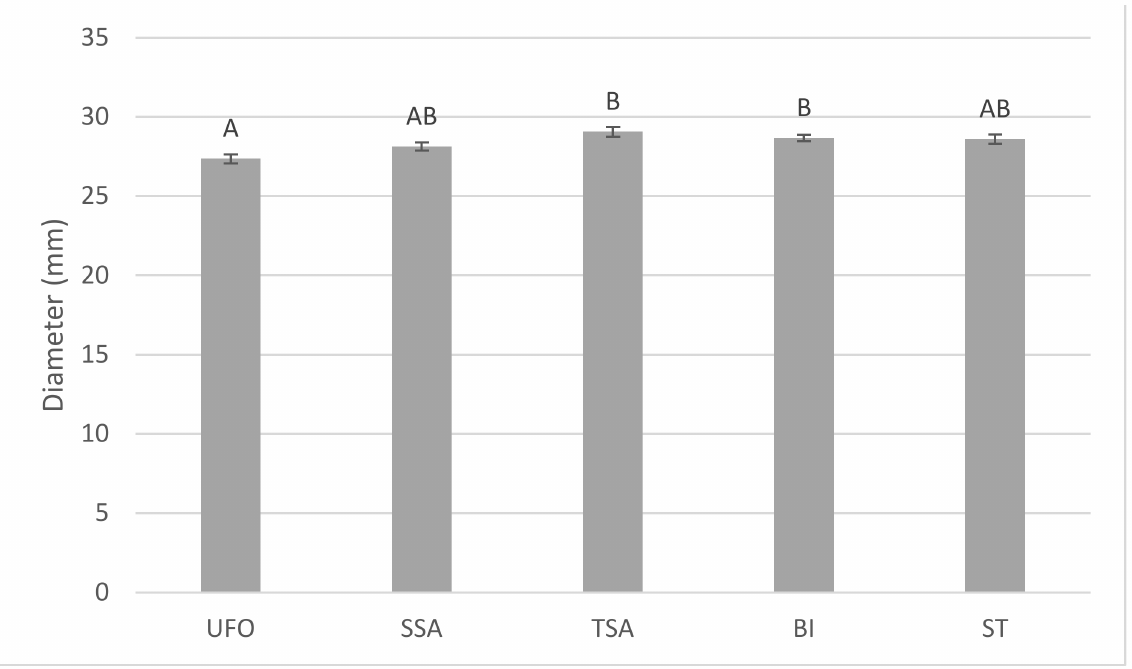
Figure A2. Mean fruit diameter weight of sweet cherry cultivar ‘Kordia’ in different training systems and seasons. Different letters above the means indicate significant difference ( p ≤ 0.05) between training systems.